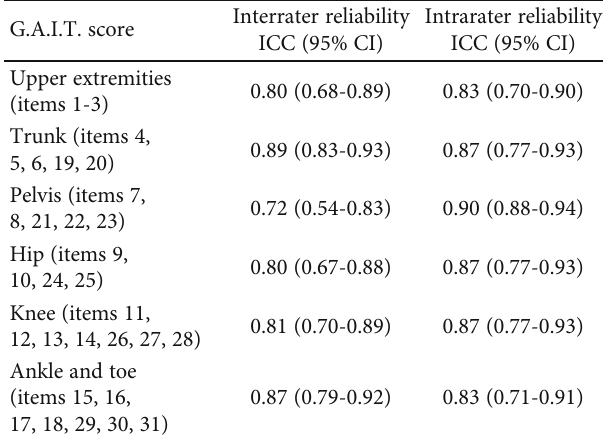
Table 4: Inter- and intrarater reliability of Thai G.A.I.T. scale classi fi ed by